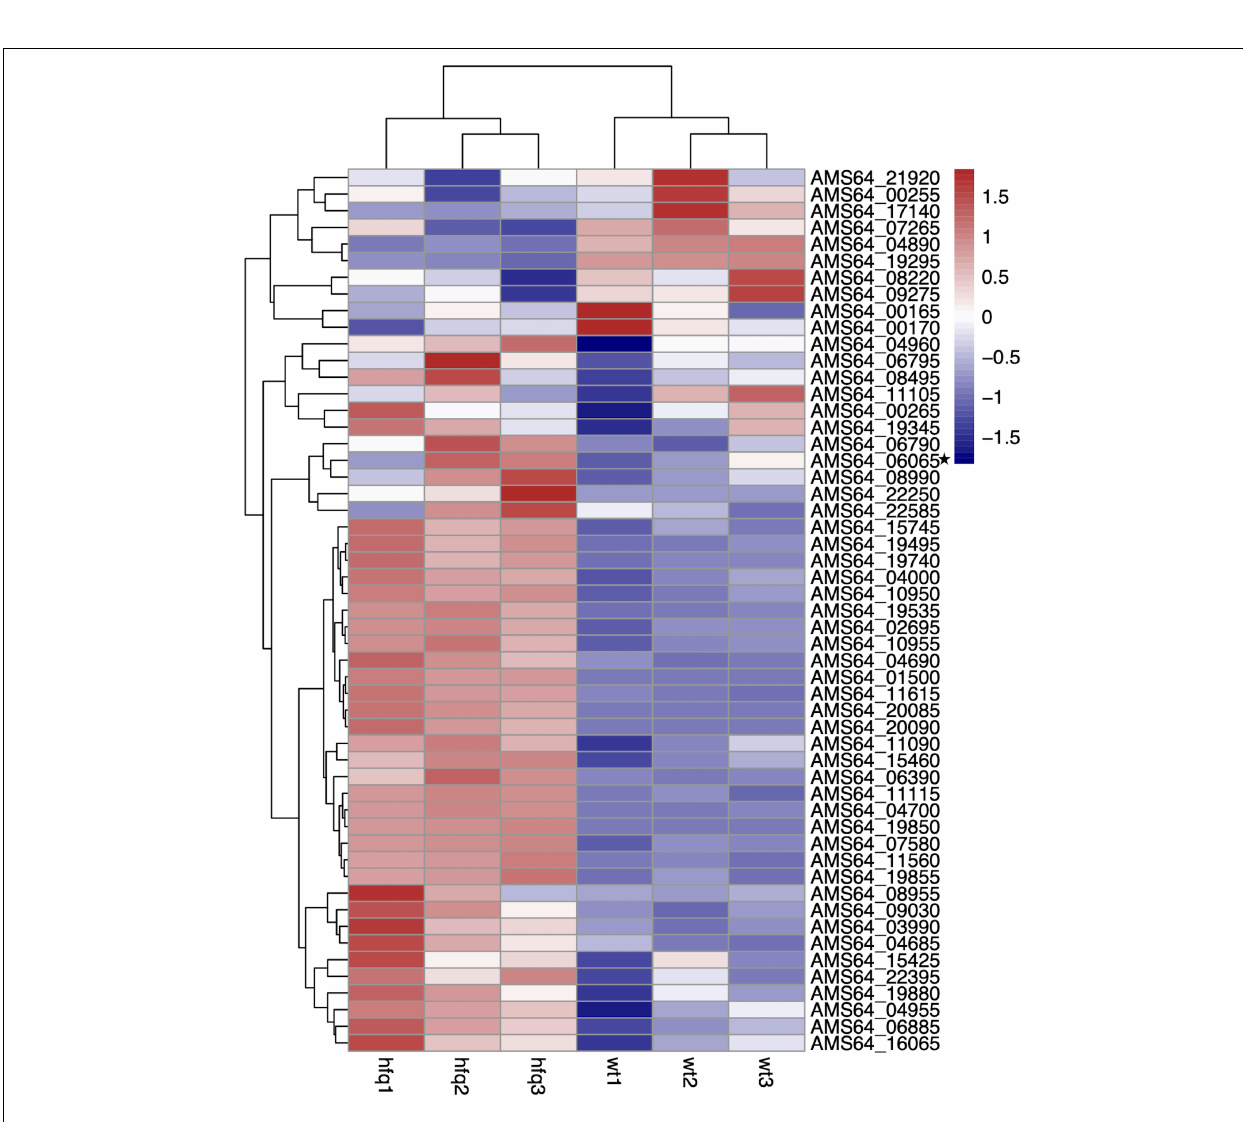
Frontiers in Microbiology |